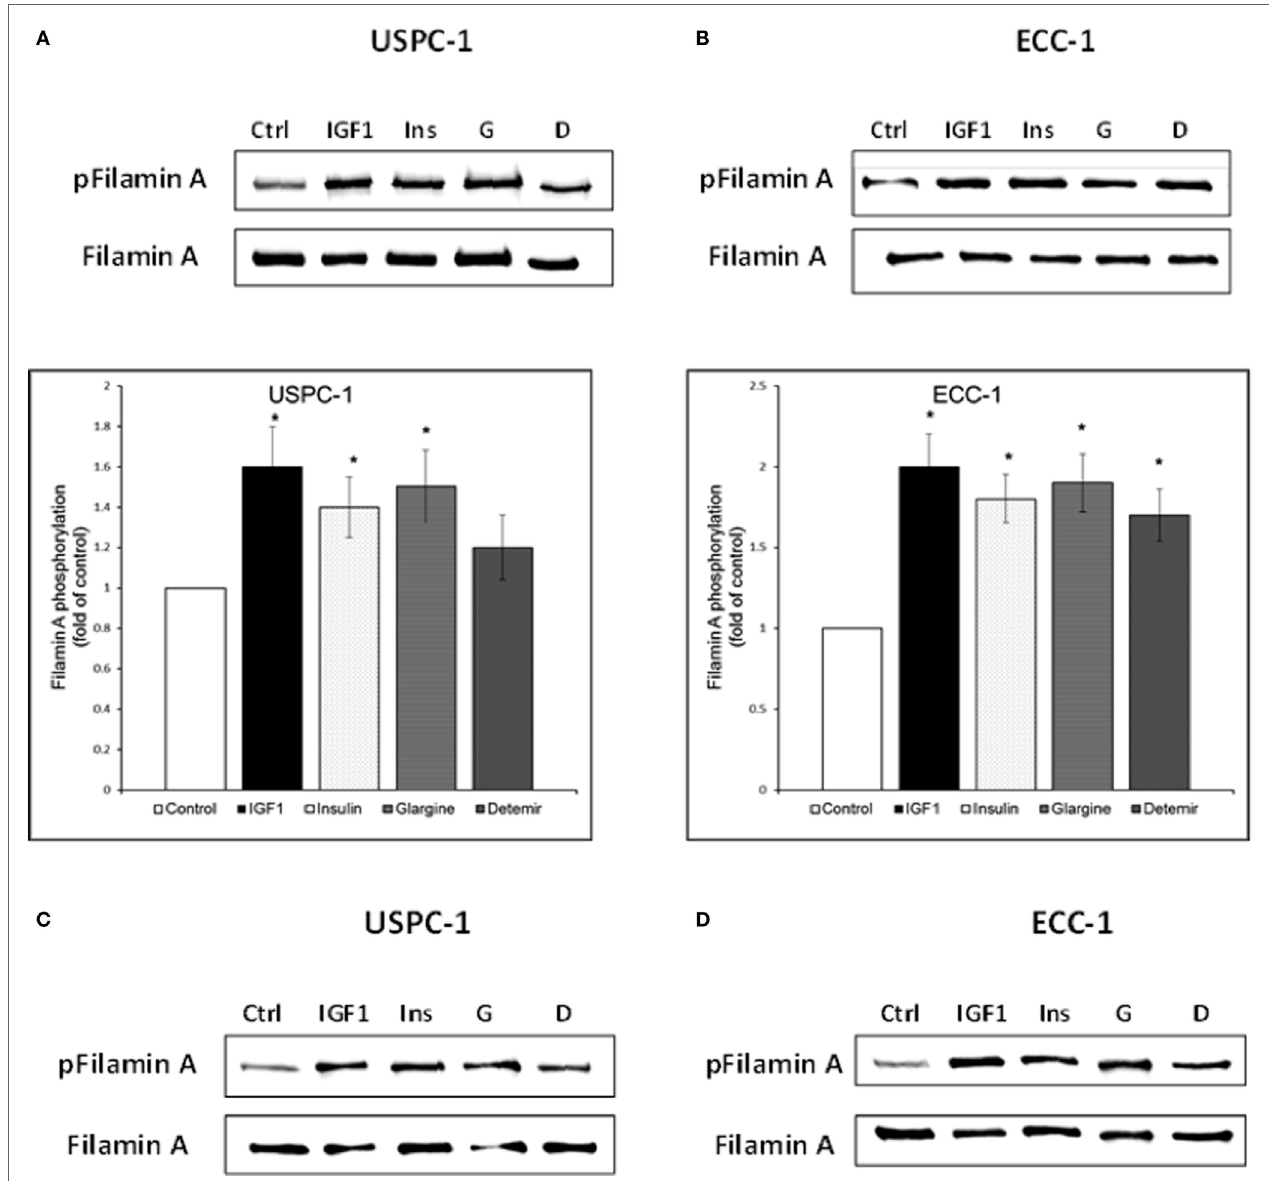
FigUre 11 | Filamin-A (FLNA) phosphorylation by insulin-like hormones. Starved USPC-1 and ECC-1 cells were treated with IGF1, insulin, glargine, or detemir at a dose of 50 ng/ml for 10 min (a,b) , or 8 h (c,D) . Cells were lysed and extracts (100 µg) were electrophoresed and immunoblotted with antibodies against phospho-filamin-A. Membranes were stripped and incubated with antibodies against total FLNA. Fold of control was obtained by normalizing levels of the phospho-protein by total protein levels and then comparing with untreated cells. Bar graphs represent three independent experiments; * p < 0.05, ligand-treated vs.